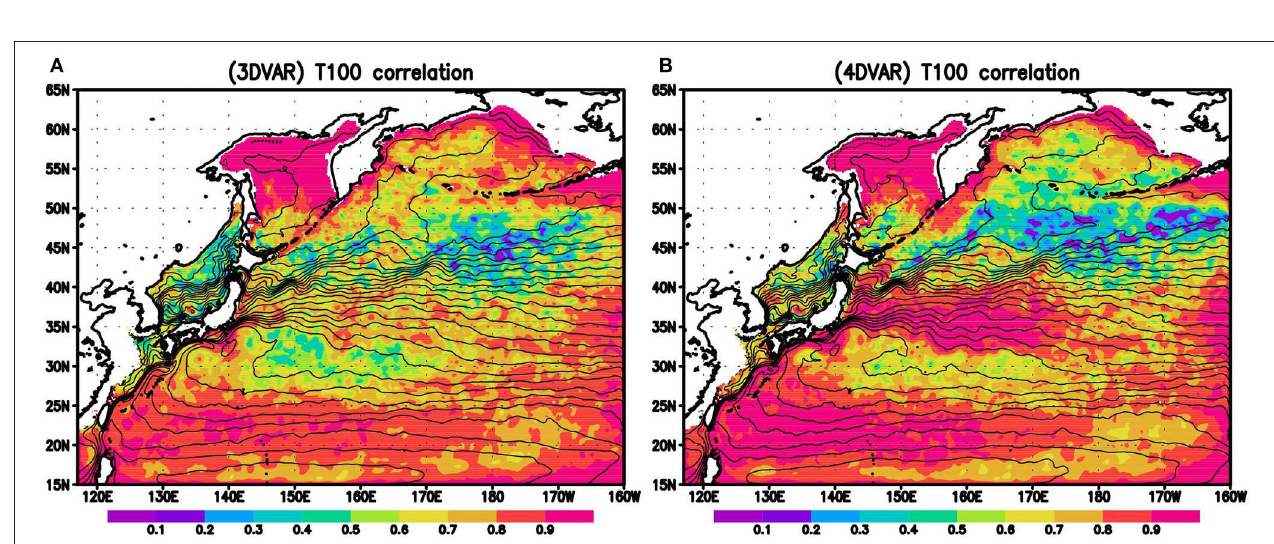
FIGURE 13 | Impacts of in-situ temperature and salinity profiles in (A) 3DVAR and (B) 4DVAR versions of JMA’s operational western North Pacific ODAP system. Panels show correlation coefficients of 100-m-depth temperature anomaly with respect to the monthly climatology between assimilation runs with and without assimilating in-situ temperature and salinity profiles. The correlation is calculated for 2005–2011. Low correlation indicates high impact.